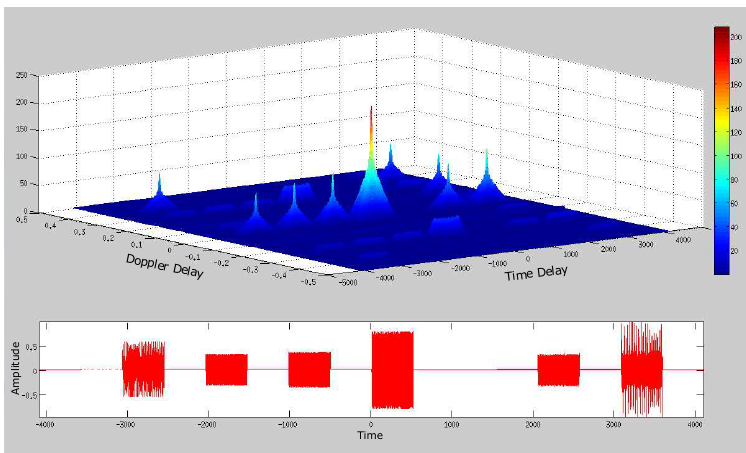
Figure 25. Multiple object tracking using MMPP “chirp pulses”, at Tracking Time 1, with no noise.